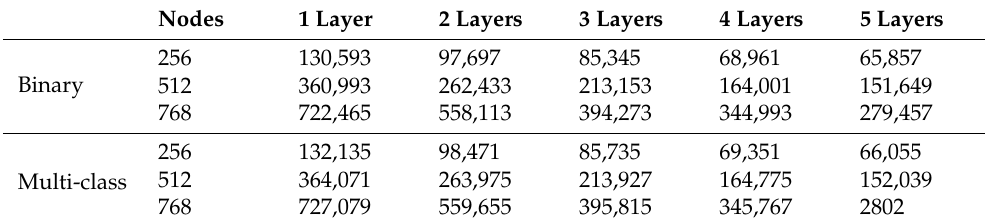
Table 16. The number of parameters of the CNN + RNN model. Nodes